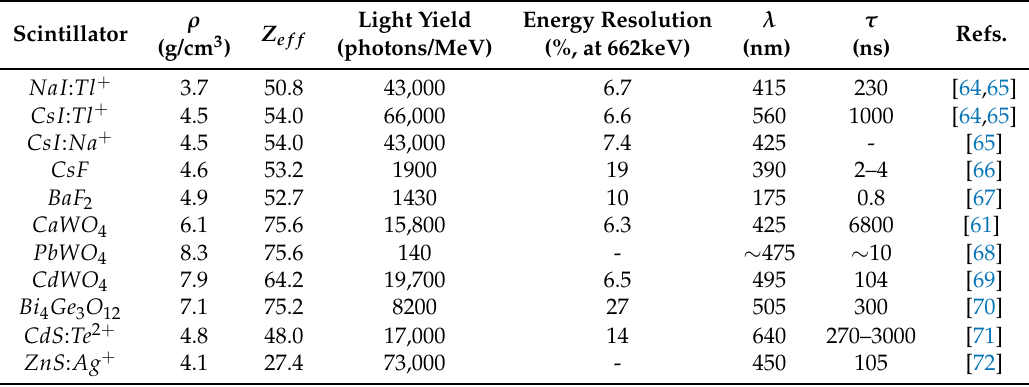
Table 1. Overview of some traditional inorganic scintillators for X-ray and γ -ray detections. The abbreviations in the heading denote the density ( ρ ), the effective atomic number ( Z ef f ), the emission wavelength ( λ ) and the main scintillation decay time ( τ ).